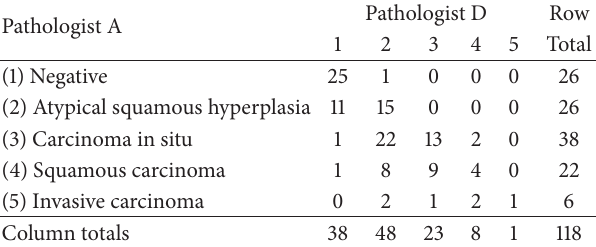
Table 1: Frequencies of pairwise classifications of carcinoma by pathologists A and D [41].